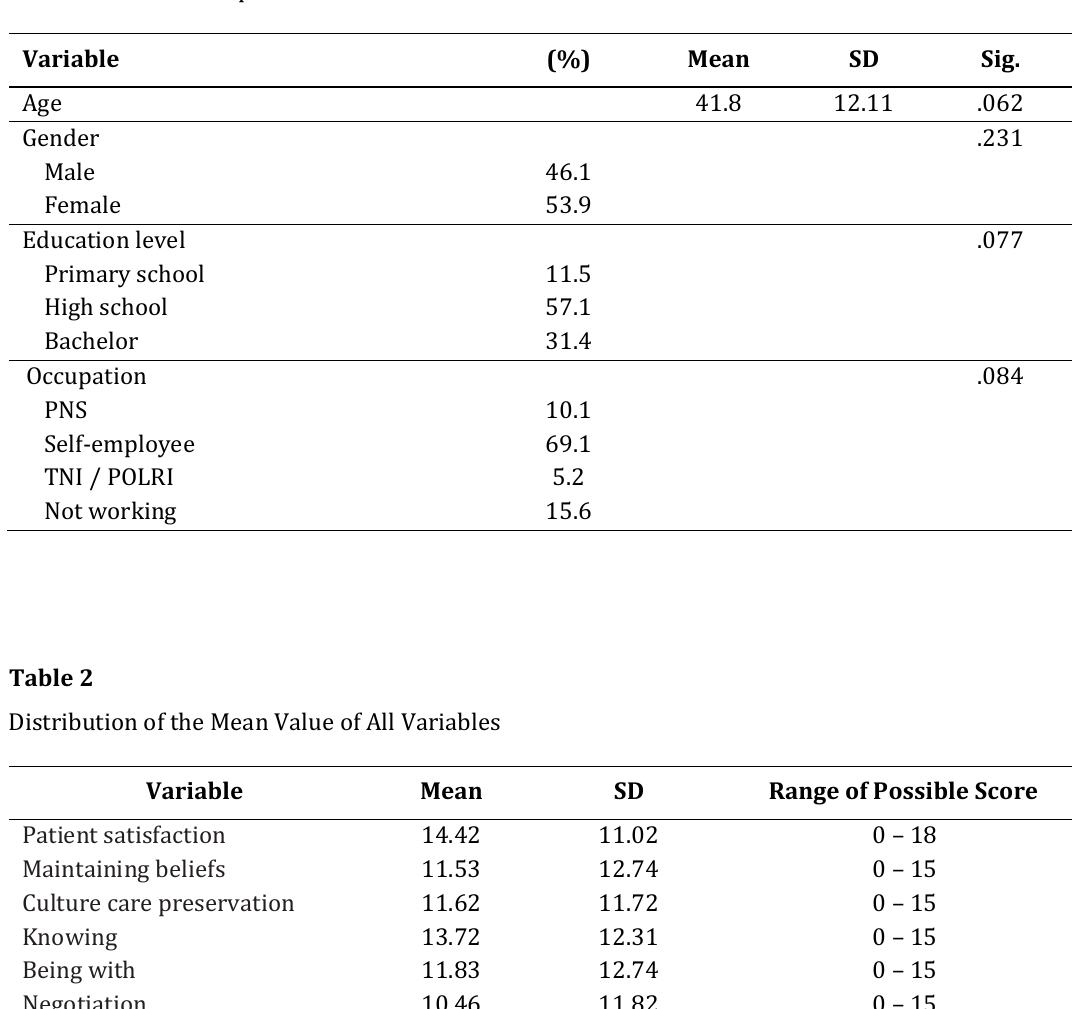
Being with Negotiation Doing for Enabling